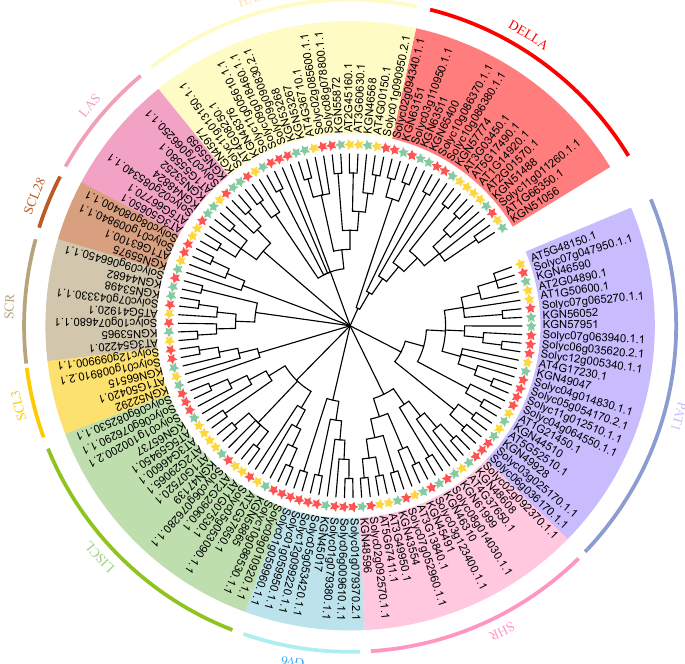
Figure 1. Phylogenetic tree of CsaGRAS genes in Cucumber, Arabidopsis and Tomato. The phylogenetic tree was constructed by the Neighbor-joining method, with 1000 bootstrap repeats. 10 classifies are represented by di ff erent colors, and the name of each subfamily is also marked in the corresponding position. The GRAS genes of the three species are represented by di ff erent colors stars: green for cucumber, yellow for Arabidopsis and red for tomato.